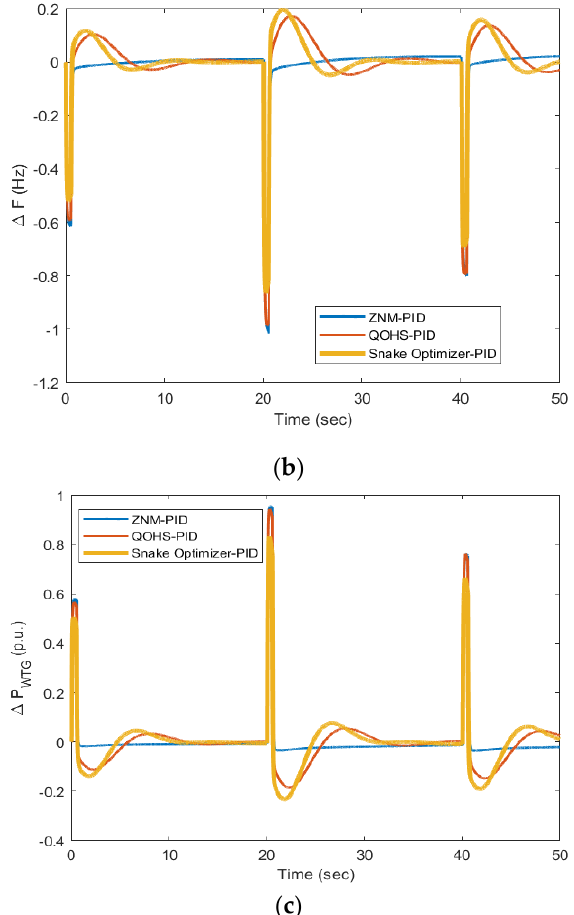
Figure 9. ( a – c ) Output of diesel–wind isolated system for load alterations at different instant of time.